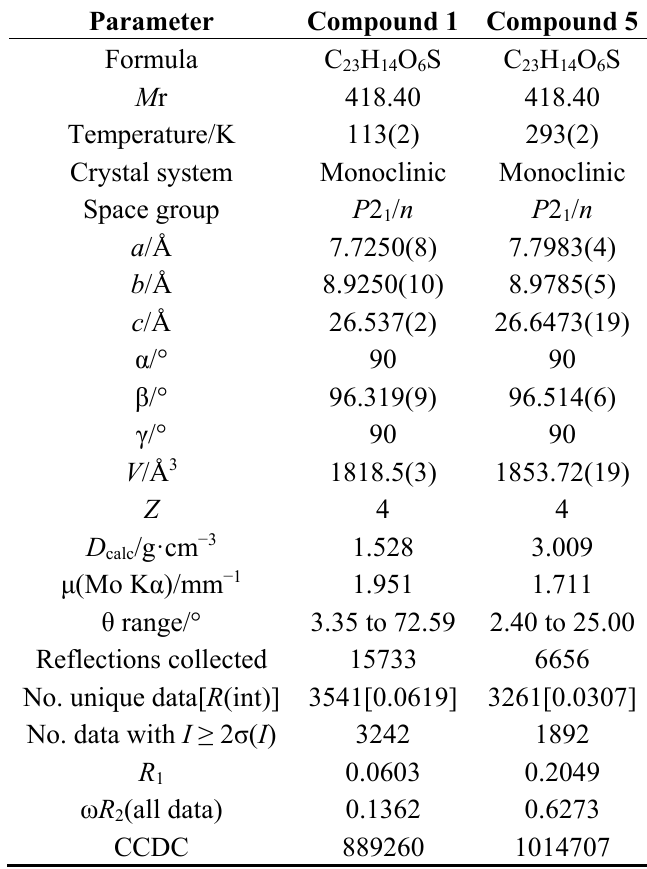
Table 4. Crystal data, data collection and structure